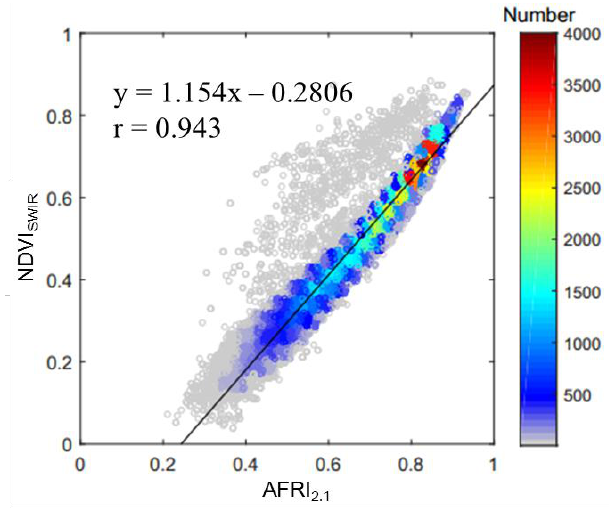
Figure 7. The relationship between NDVI SWIR and AFRI 2.1 . Both NDVI SWIR and AFRI 2.1 are calculated using MODIS surface reflectance products. The color bar shows the number for each point.